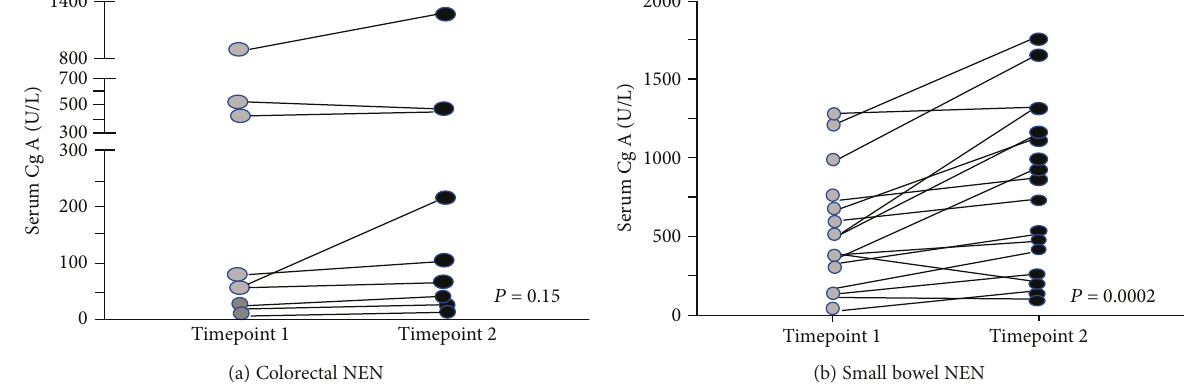
Figure 3: Plasma Cg A in patients with con fi rmed progression of colorectal NENs. Baseline levels and concentration of Cg A during follow- up of patients with metastatic colorectal NENs is no di ff erent (a) as observed during small bowel neuroendocrine tumor progression (b) [65].